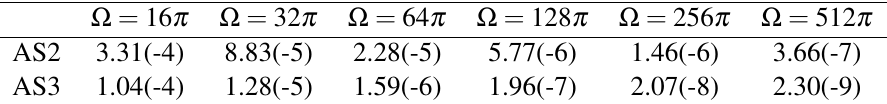
Table 1 Maximum errors in u , with respect to the true solution, for the second-order and the third-order averaged solutions in the interval 0 ≤ t ≤ 2. The notation 3 . 31 ( − 4 ) means 3 . 31 × 10 − 4 ,